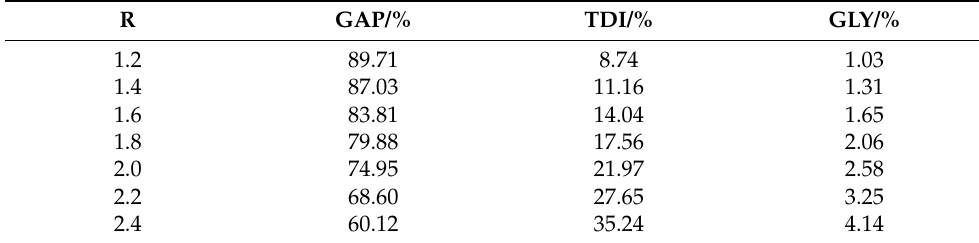
Figure 1. Schematic illustration for the preparation process of polymer films. Table 1. Feeding ratio of polymer films with different